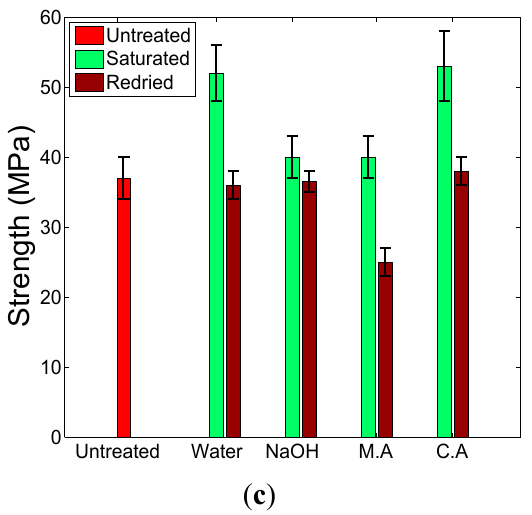
Figure 5. Variations in mechanical properties of the NFC under different chemical treatments obtained through tensile tests, ( a ) elongation; ( b ) stiffness and ( c )